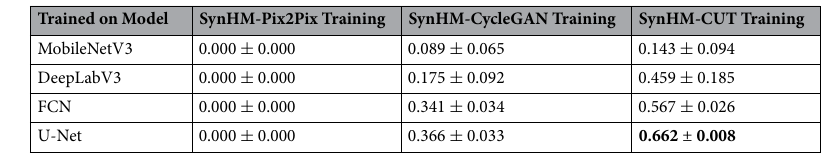
Table 4. Comprehensive comparisons from the 12 combinations among the 4 segmentation models and 3 synthesized datasets for style transfer model training. The statistical F 1 inst : 0.1 are reported as the mean value of 10 independent runs with the standard deviation for each configuration. * SynHM stands for synthetic historical map. Significant values are in [bold].